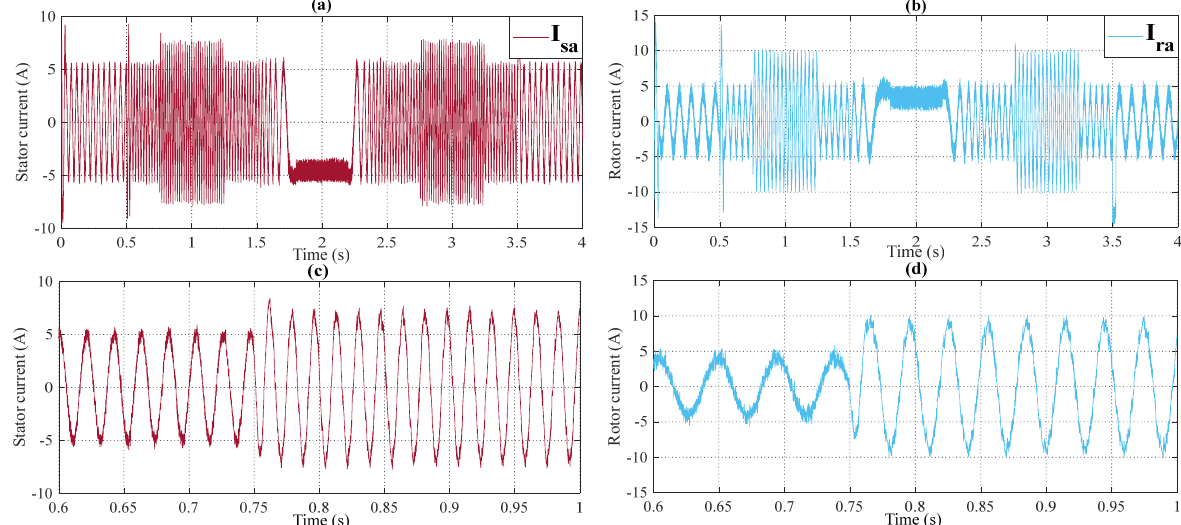
Figure 15. Stator ( a , c ) and ( b , d ) rotor currents responses of intelligent ACO-DTC. Figure 16. Stator ( a ) and rotor ( b ) THDs of an ACO-DTC. Figure 16. Stator ( a ) and rotor ( b ) THDs of an ACO-DTC.